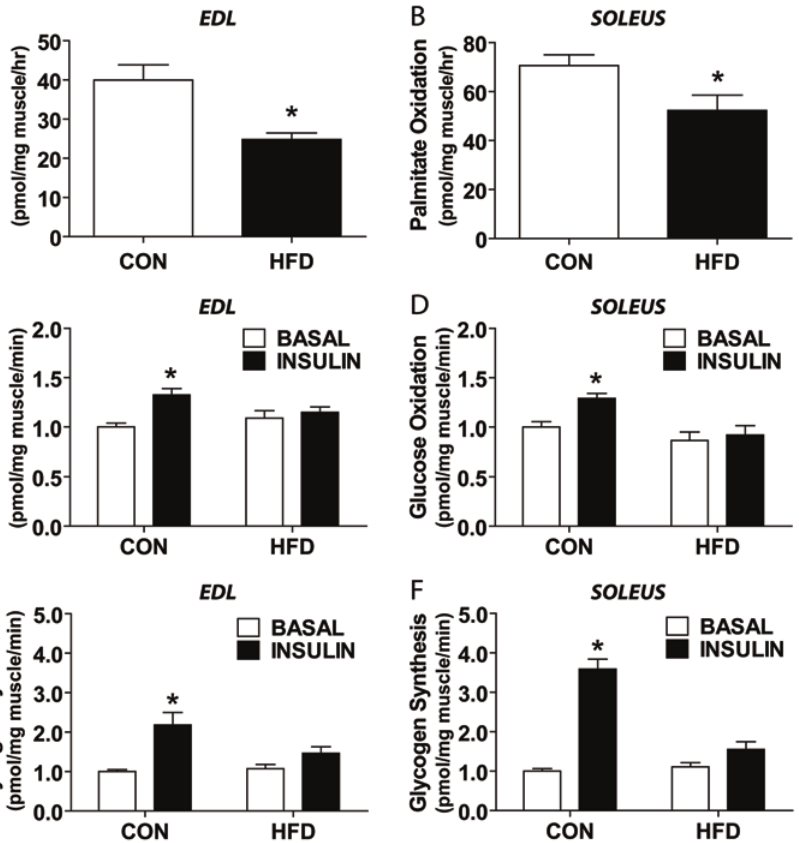
Figure 4. Impaired oxidation, glycogen synthesis, and insulin stimulated response in HFD muscle. Palmitate oxidation in whole (A) EDL (N=4) and (B) soleus (N=4) muscles is impaired with HFD. Both glucose oxidation in whole (C) EDL and (D) soleus and glycogen synthesis in whole (E) EDL and (F) soleus muscles with HFD demonstrate a significant blunted response to insulin pre-incubation (INSULIN), vs. no insulin pre-incubation (BASAL), in HFD muscle (N=4–6, two-way ANOVA with Bonferonni post-tests between insulin conditions within diet). Significance is represented by * vs. CON (A–B), and vs. INSULN (C–F), p , 0.005.